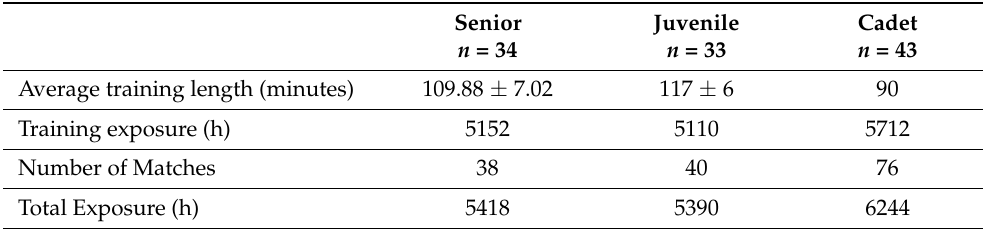
Senior n = 34 n = 33